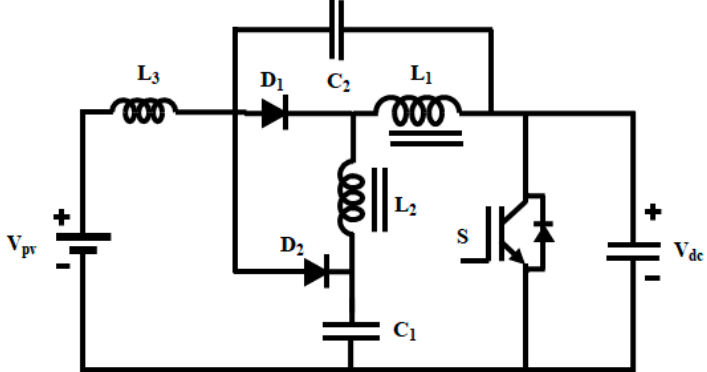
Figure 3. Proposed switched clamped diode boost (SCDB) converter.